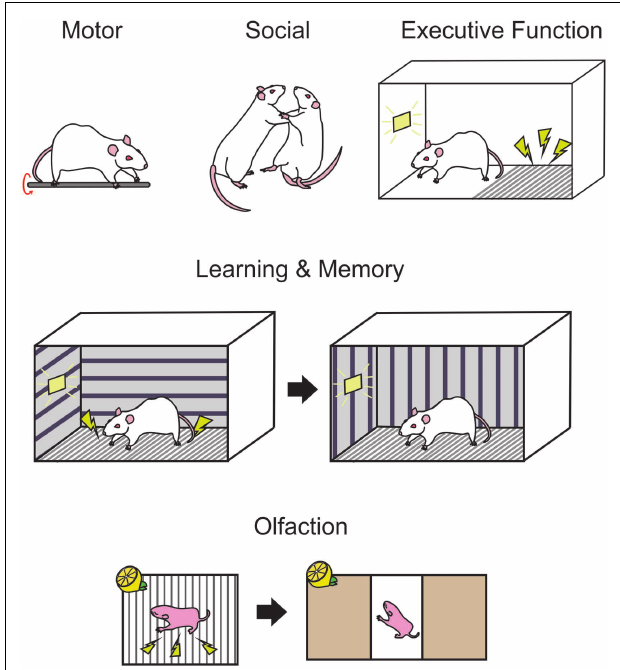
FIGURE 2 | Standardized behavioral measures are used in rodents to examine the functional consequences of developmental ethanol exposure . Motor performance in rodents may be measured on tasks such as the rotarod (upper panel, left-most) where the animal must balance and run on a rotating rod. Social interactions, such as evidence of aggressive behavior can be deduced by observations of wrestling, rearing, and pinning (upper panel, middle) when two conspecifics are paired. Passive avoidance (upper panel, right-most) is a measure of executive behavior in rodents where the animal must learn to inhibit exploratory behavior in order to avoid a shock for the duration of a trial, as indicated by a light.Trace fear conditioning (middle panel) is a hippocampal-dependent behavior where the animal is trained in a context where a signal such as a light indicates a footshock, then after a delay in placed in a novel context and freezing responses can be measured while the light is presented without the footshock. Associative olfactory memories (bottom panel) are formed when an odor, such as lemon is paired with a stimulus such as a footshock and may be tested in a two choice preference chamber, where orientation toward or away from an odor can indicate the presence of a memory for that